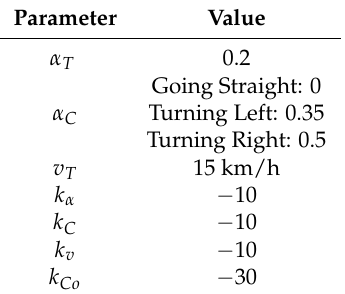
Table 2. Parameter settings in Equation (2).